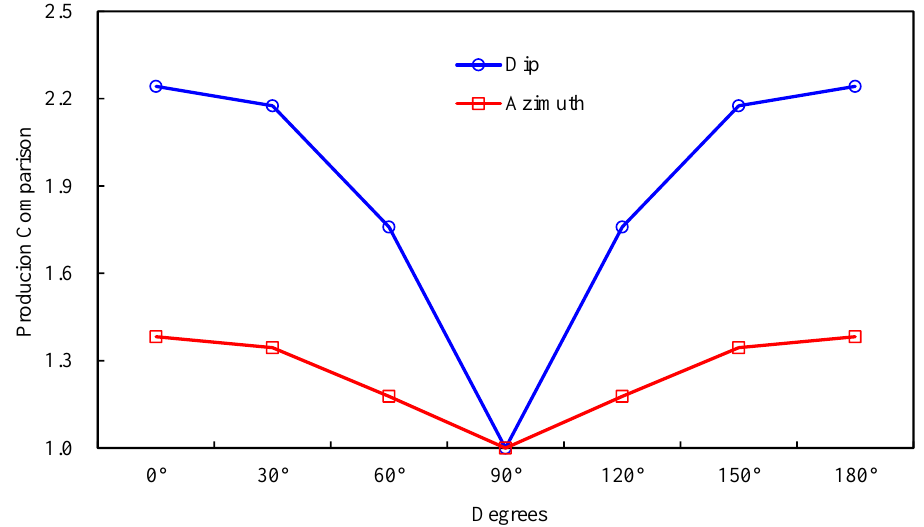
Figure 11. The ratio of production at different dip (or azimuth) and production at dip (or azimuth) of 90° when fractured horizontal well produced after 600 days.